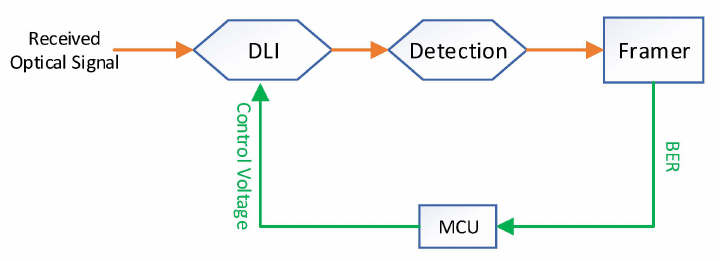
Figure 4. Improved dynamic DLI control voltage